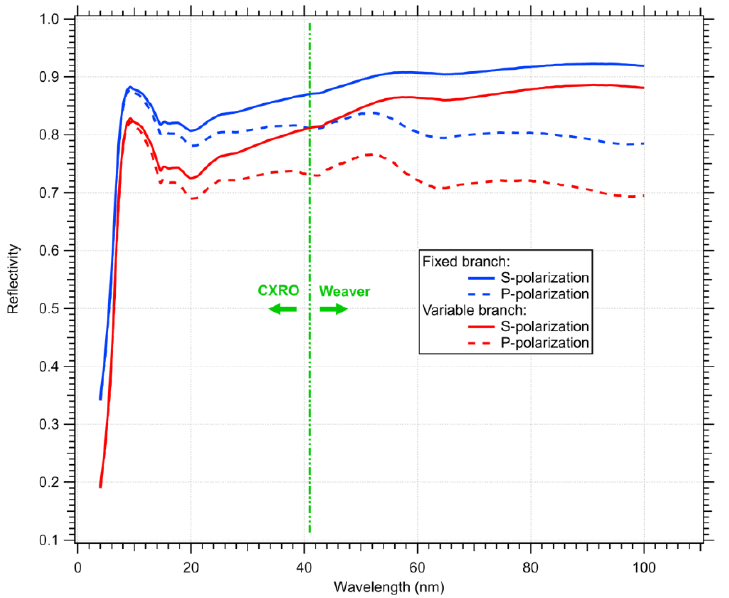
Figure 4. Calculated AC/DC reflectivity. Blue and red lines refer to the fixed-length and variable- length optical branch, respectively.